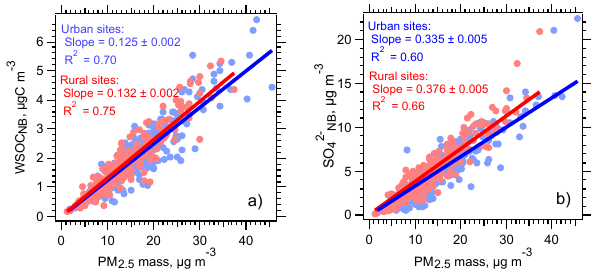
Fig. 3. Scatter plots of (a) WSOC NB and (b) Sulfate NB (non- biomass-burning) versus PM 2 . 5 mass concentrations. Slope and R 2 of the linear fit are shown separately for urban and rural sites.